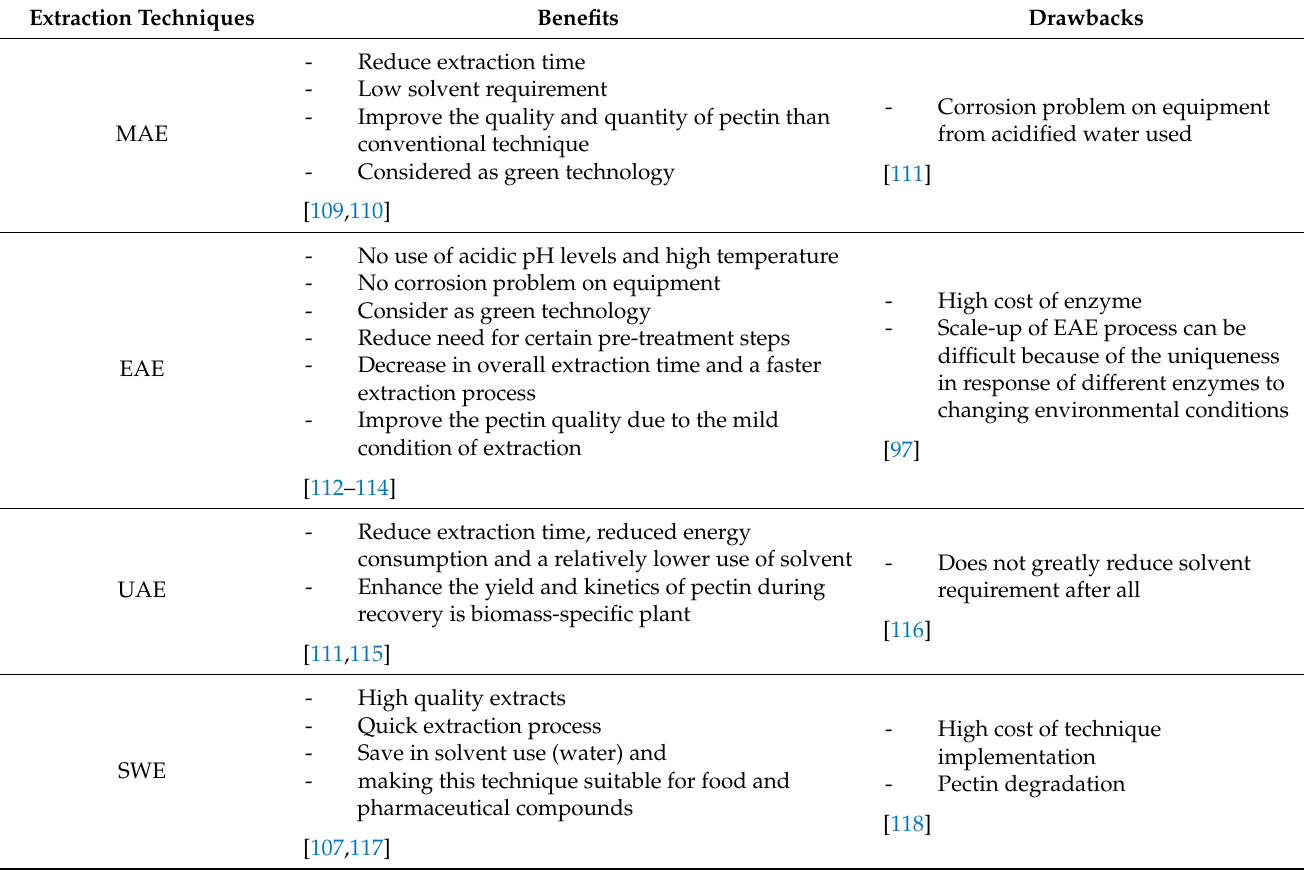
Table 4. Benefits and drawbacks of the novel